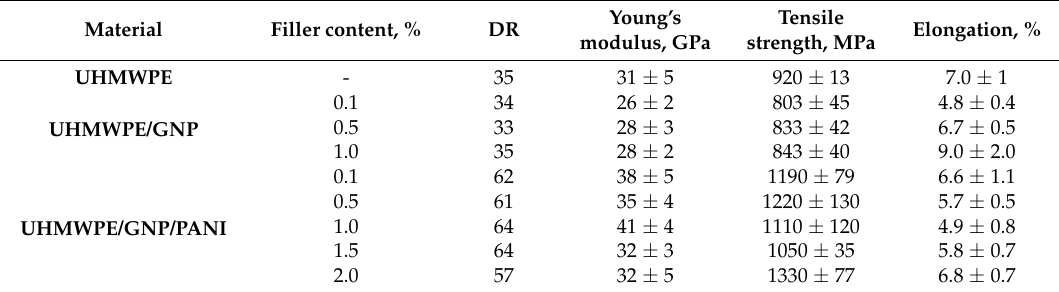
Table 2. Mechanical tensile properties of the UHMWPE films with different filler content ( ± the standard